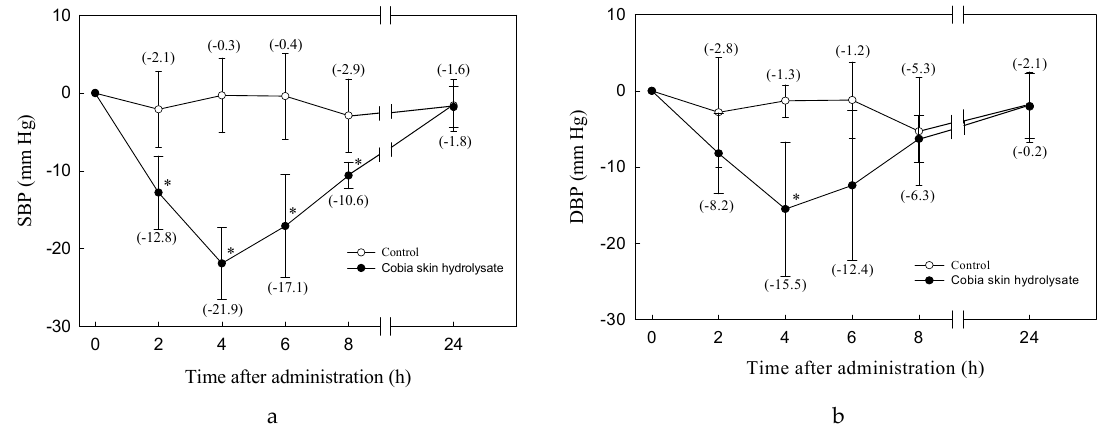
Figure 1. The effect of oral administration of PX-5 on blood pressure in SHRs. ( a ) systolic blood pressure (SBP); ( b ) diastolic blood pressure (DBP). — ○ —, control = 0.9% NaCl in deionized water; —●— , 210 mg of hydrolysate in 0.9% NaCl; Each value is a mean of five readings. The bars indicate standard error. *: significant difference from control, p < 0.05.